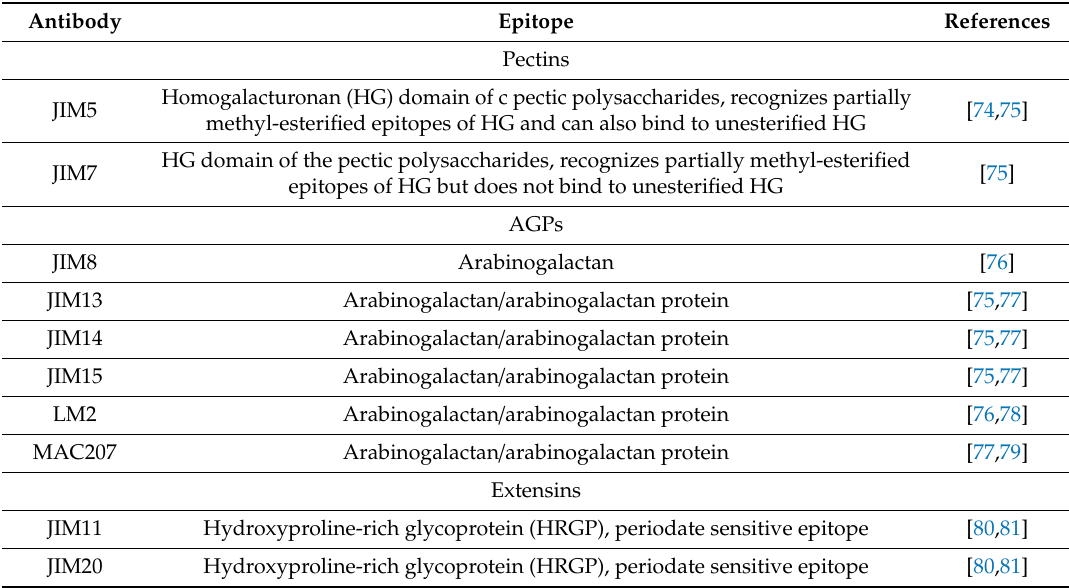
Table 2. List of the monoclonal antibodies used in the current study, the epitopes they recognize, and